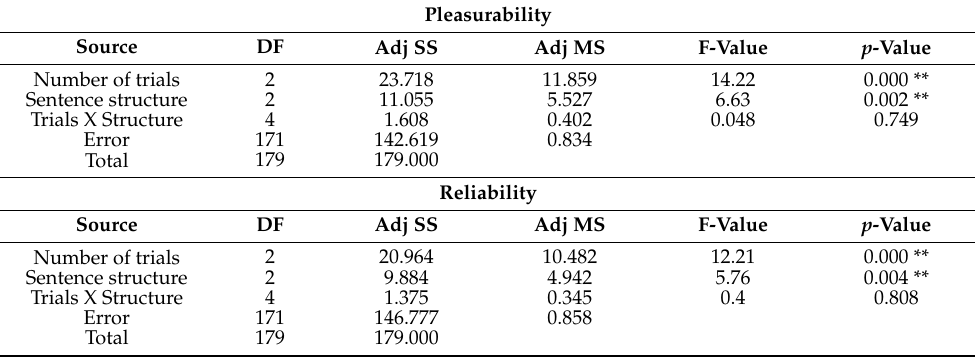
Table A5. Two-way ANOVA for “Number of Trials and Sentence structure”. **: p -value <